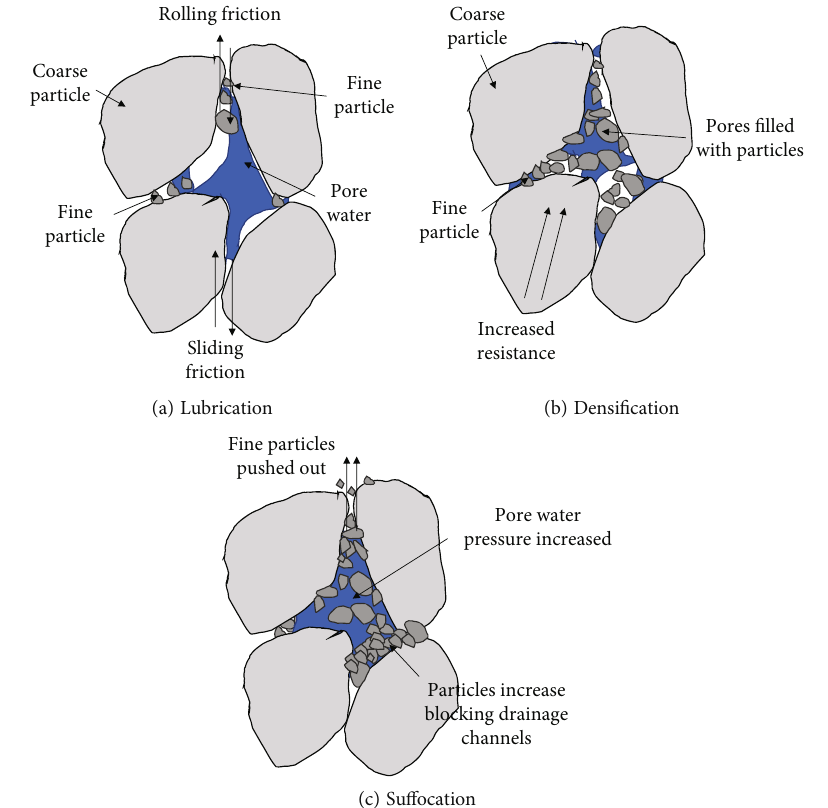
Figure 16: E ff ect of fi ne particles on permanent axial strain.